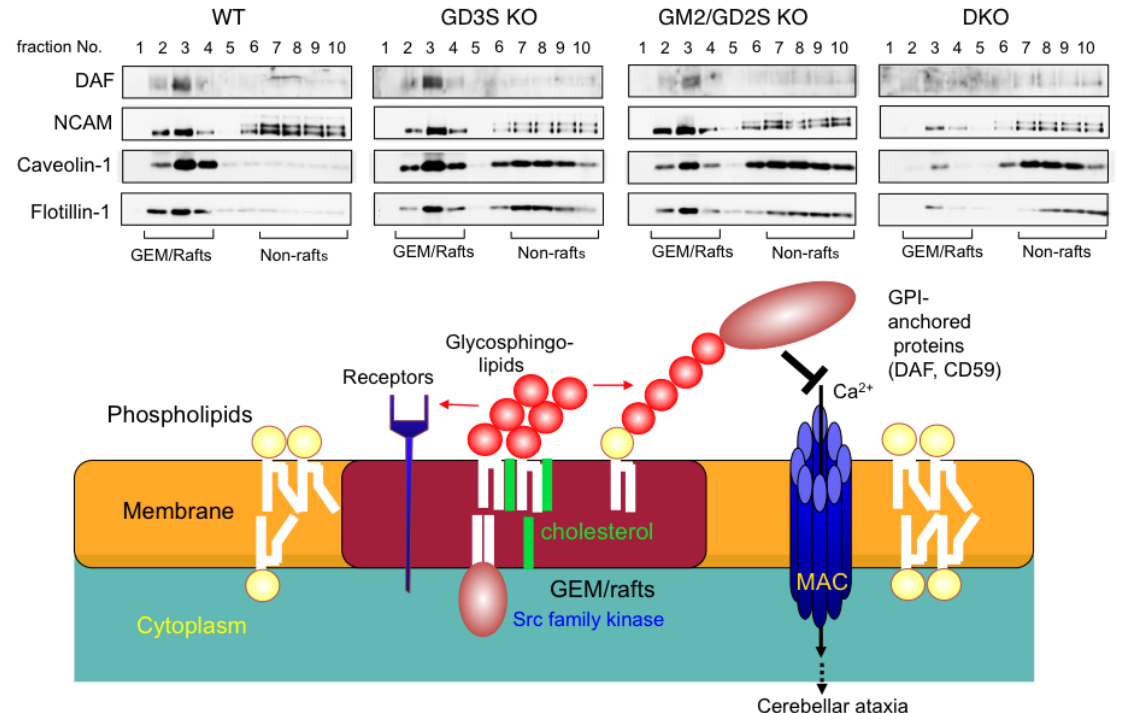
Figure 5. Destruction of the GEM/raft induced changes in the architecture and functions of raft-localizing molecules. Localization of GPI-anchored proteins including complement-regulatory molecules changed, leading to functional abnormalities and subsequent complement activation and inflammation in ganglioside-deficient mouse brain. GPI-anchored molecules such as DAF and NCAM as well as GEM/raft markers shifted from GEM/rafts to non-rafts domains. A part of a figure in Ref. 81 was presented after modification. Among isoforms of NCAM, only the GPI-anchored one was detected in GEM/rafts.